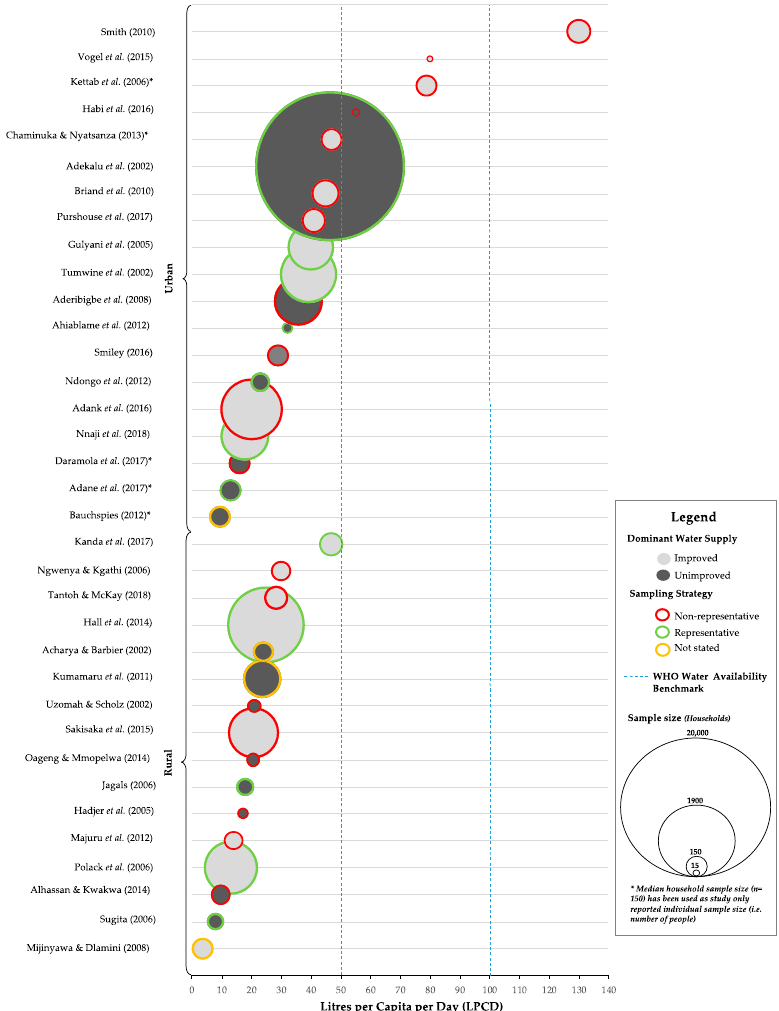
Figure 3. Daily per capita drinking water availability based on dominant household supplies, relative Figure 3. Dailypercapitadrinkingwateravailabilitybasedondominanthouseholdsupplies, relativetothe World Health Organization’s (WHO’s) benchmark of 50 to 100 LPCD